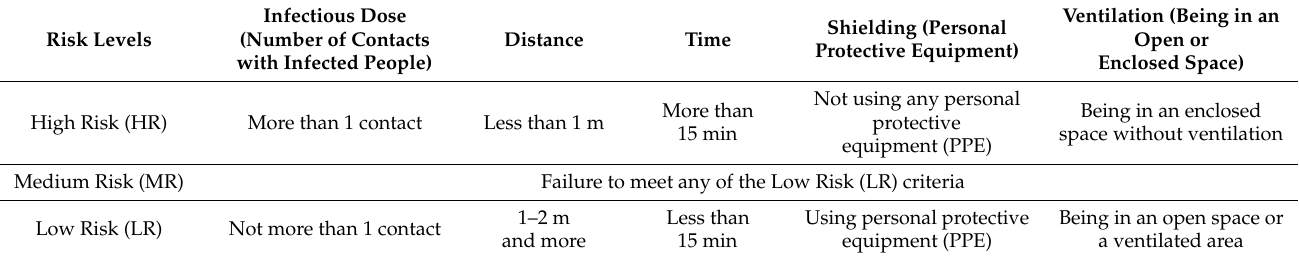
Table 1. Sechenov University COVID-19 Risk Assessment Criteria (RAC).